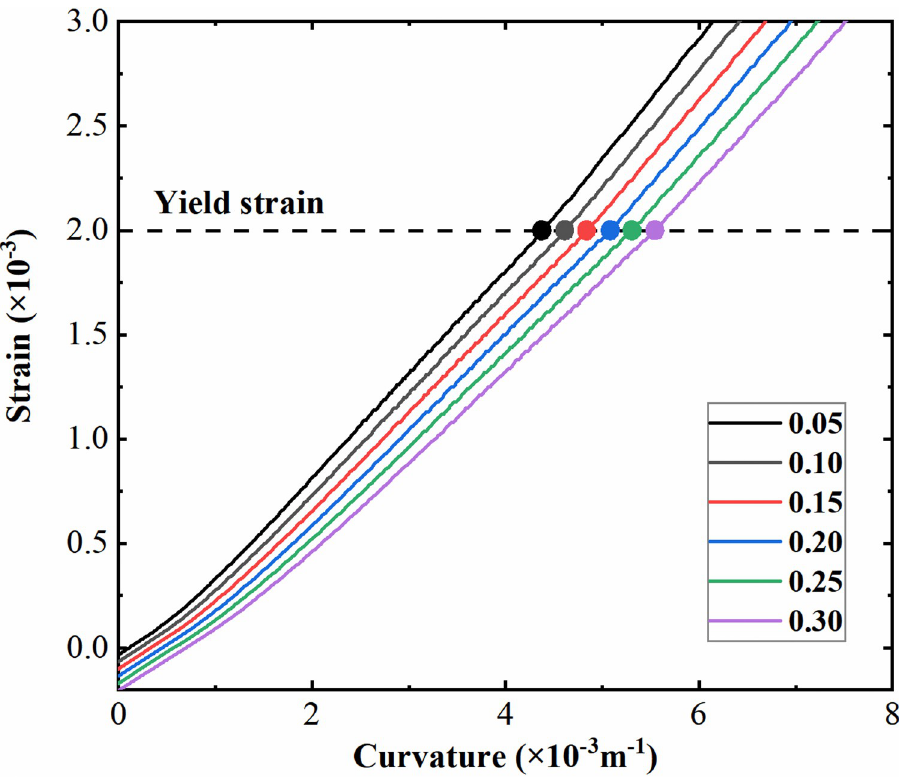
Fig 15. Strain of tensile reinforcement of the sidewall section with different axial compression